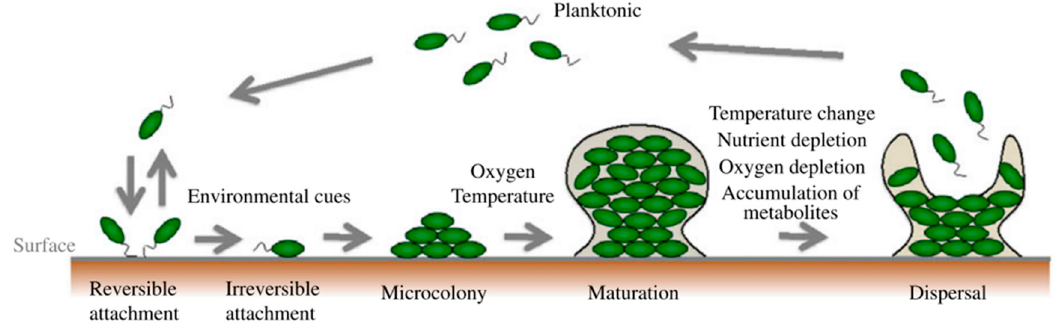
Figure 1. Biofilm formation and selected environmental factors that affect each stage [2].